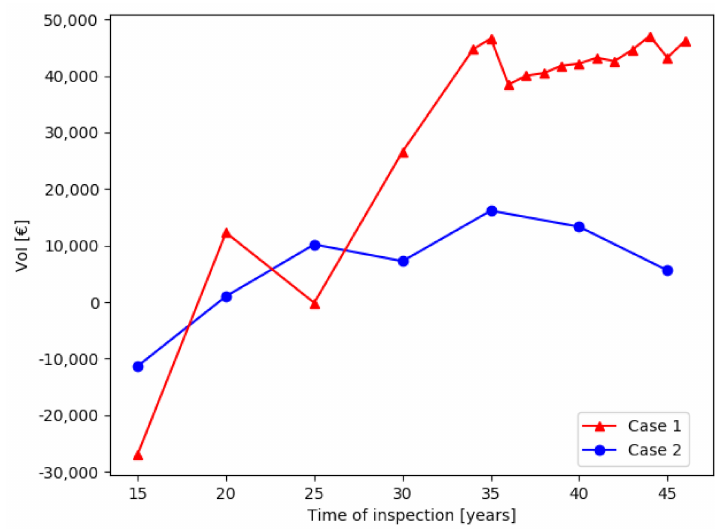
Figure 6. Influence of the time of monitoring on the VoI for the considered case